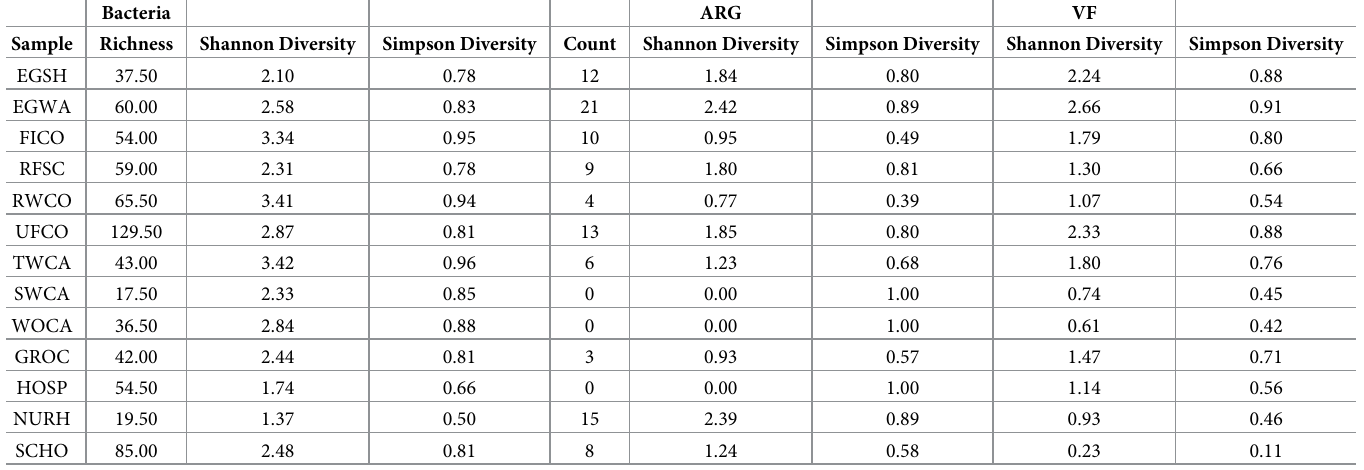
Table 4. Summary of diversity metrics for each